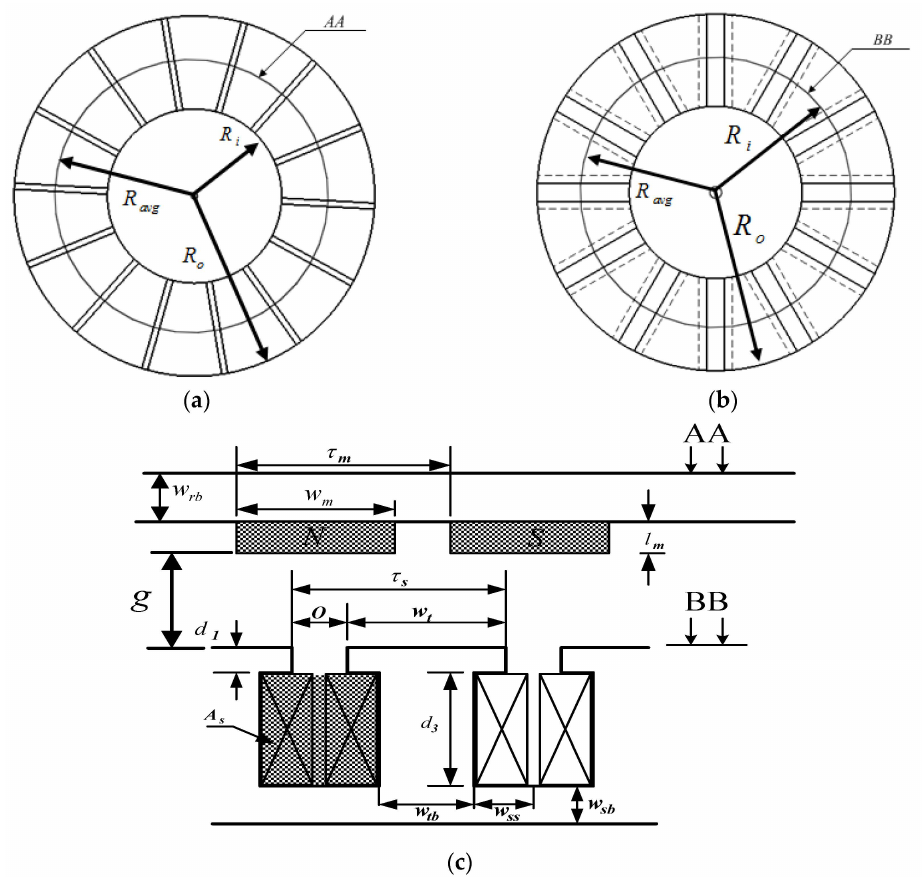
Figure 3. The ( a ) rotor; ( b ) stator; and ( c ) 2-D cross-sectional view of a single-sided